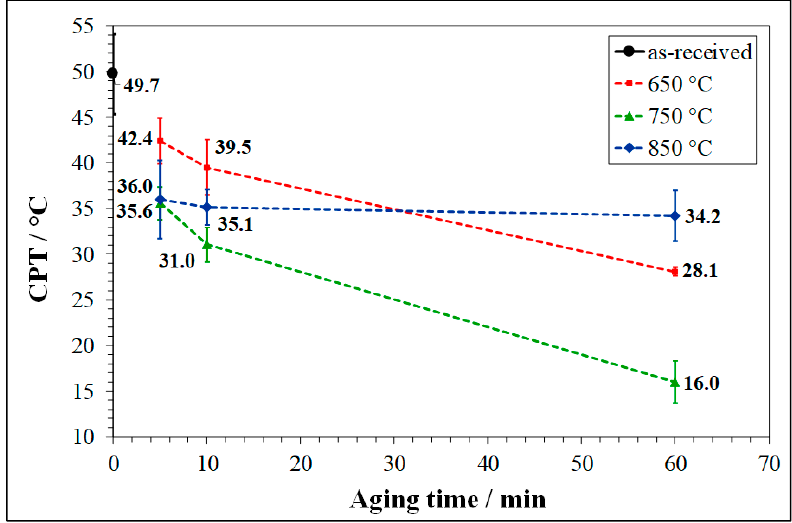
Figure 4 . Average CPT values and standard deviations determined in 0.1 M NaCl solution on LDSS 2404 electrodes as a function of aging temperatures and at different aging times.